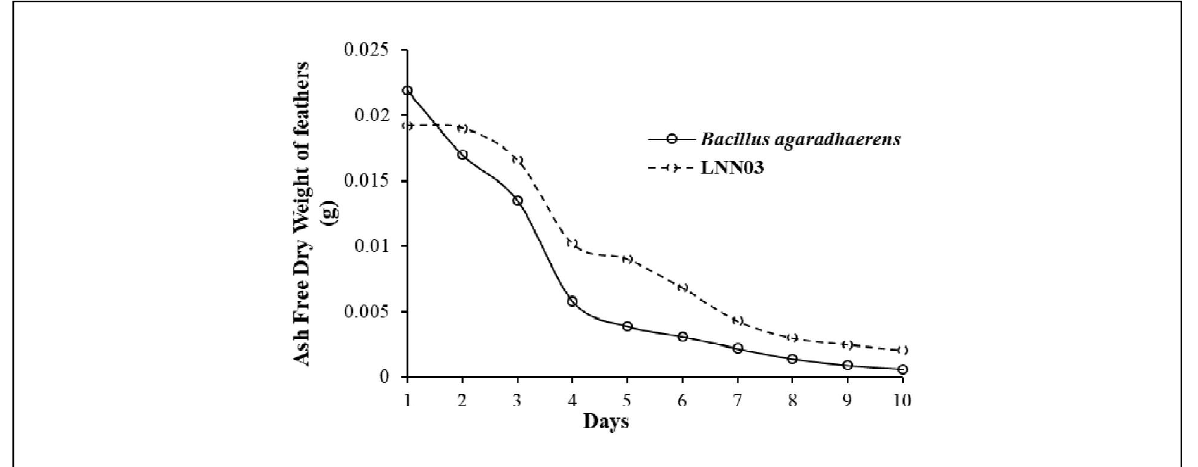
Figure 4: Profiles showing changes in ash free dry weight of chicken feathers during the assay inoculated with Bacillus agaradhaerens (LNC06) and LNN03 from Lake Nakuru for 10 days